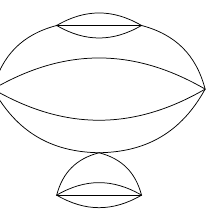
Figure 4 . A melon tadpole graph, where all the invariants have been shrunk to point-like vertices.